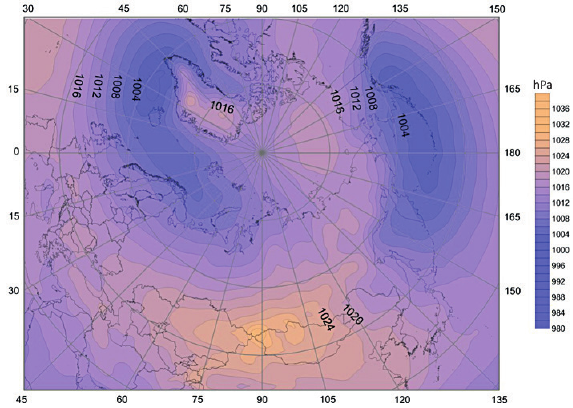
Fig. 3. SLP over the Northern Hemisphere in the cold